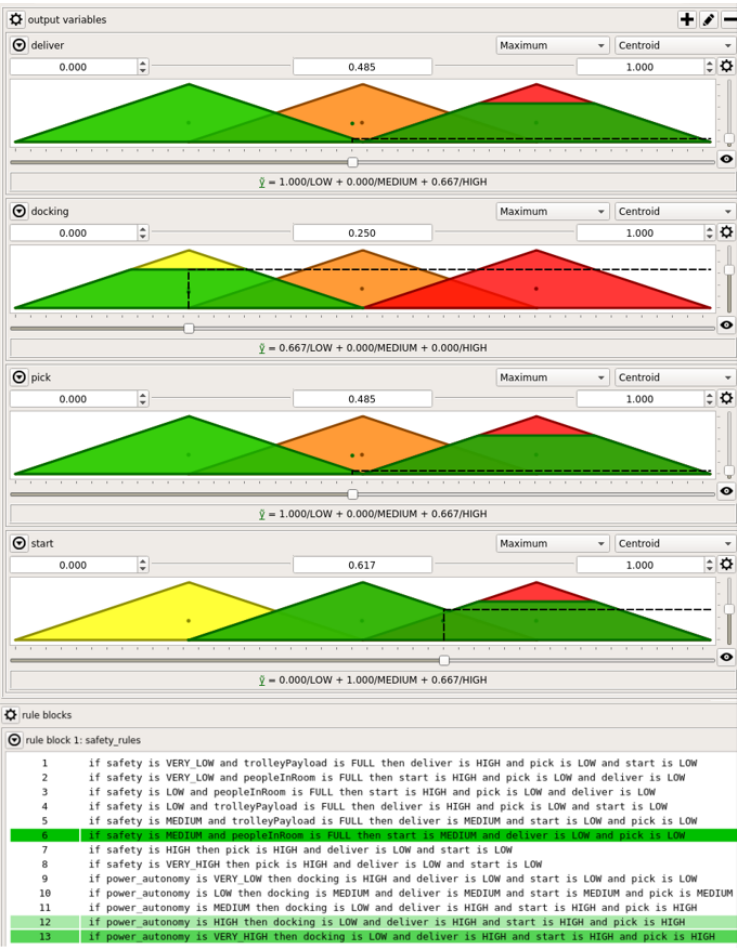
Figure 12. Tentative actions provided by the FuzzyEngine when a person is detected close to the roll container (see text).